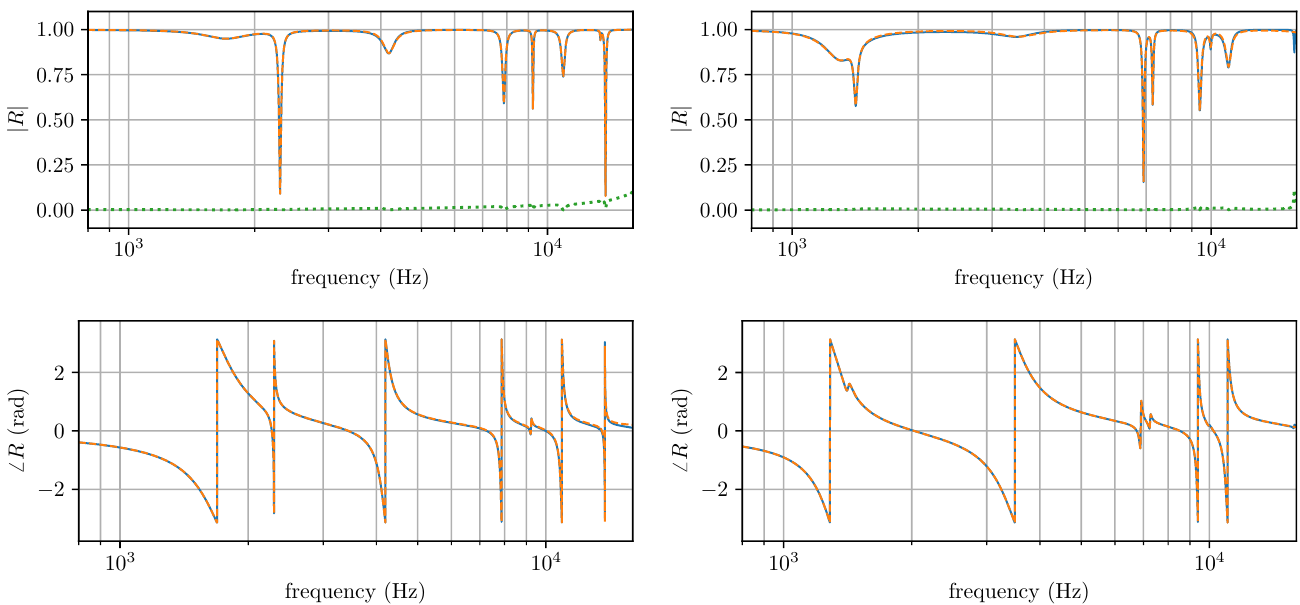
Figure 3. Magnitude and phase of the reflection coefficient using the Transfer Matrix Method (blue, solid) and using the RLC approximation (orange, dashed) relating two different slit admittances within the QRM along with fitting errors (green, dotted), as a function of frequency in